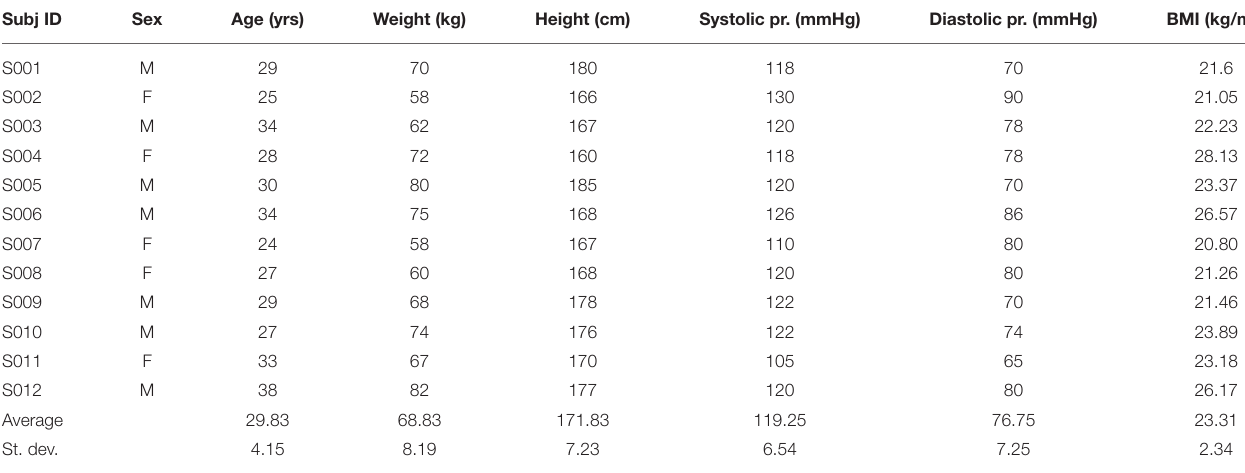
TABLE 1 | Participants anthropometrics